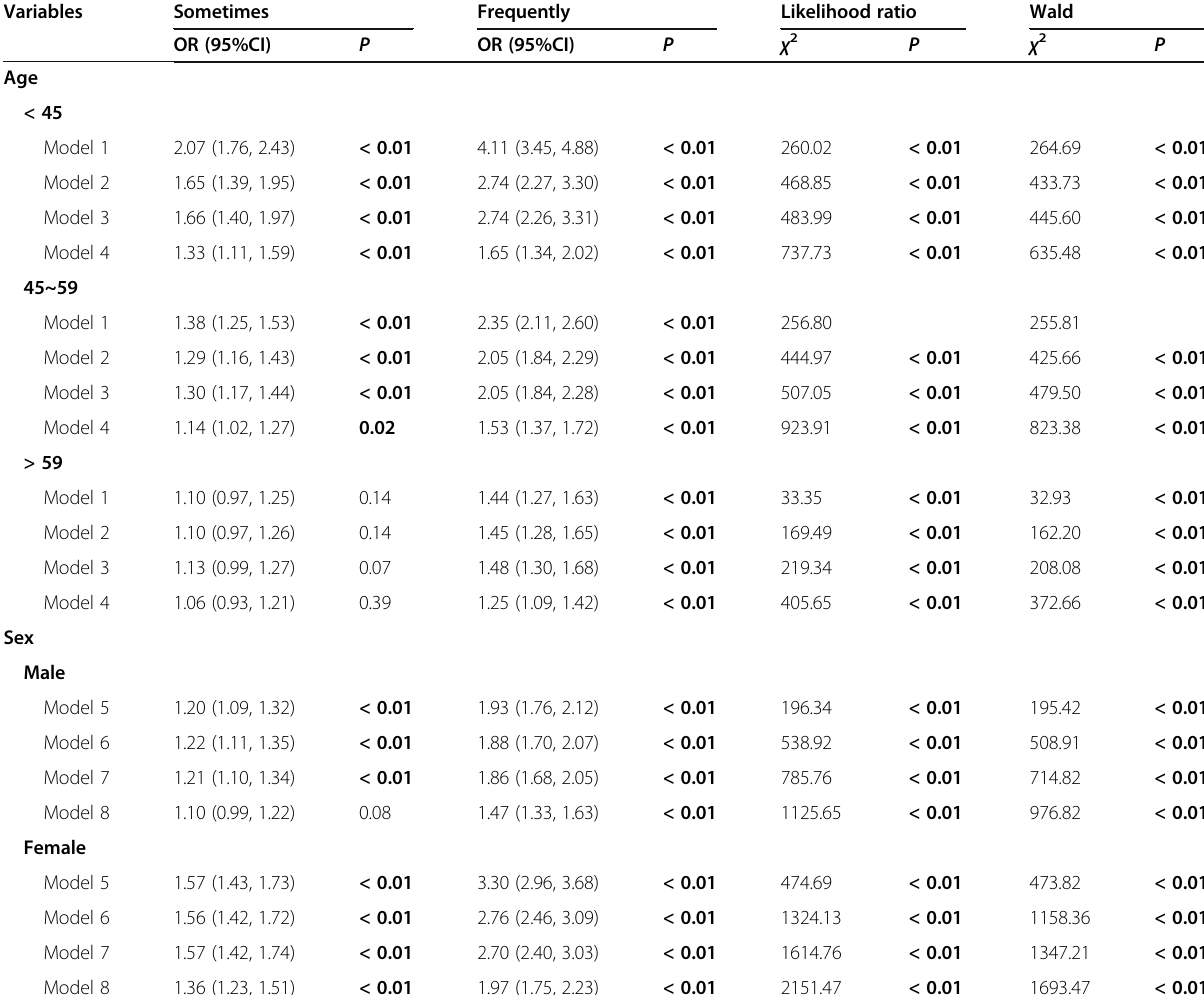
Table 3 Logistic regression of the association between self-reported snoring frequency and hypertension Variables Sometimes Frequently Likelihood ratio